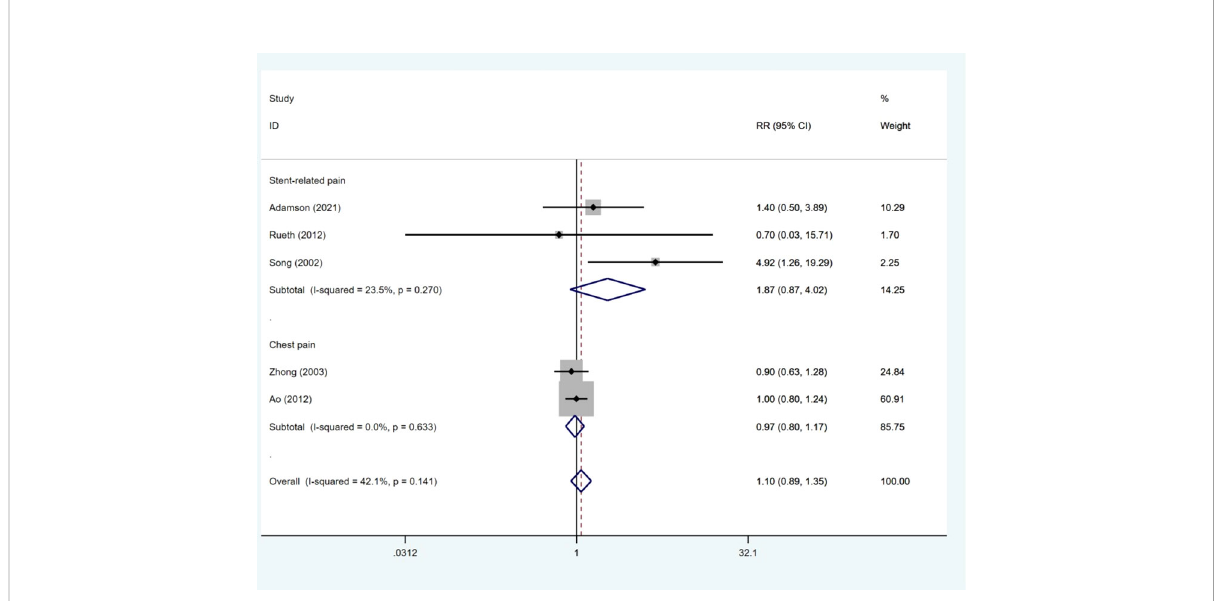
FIGURE 6 Forest plot for the results of pain events.